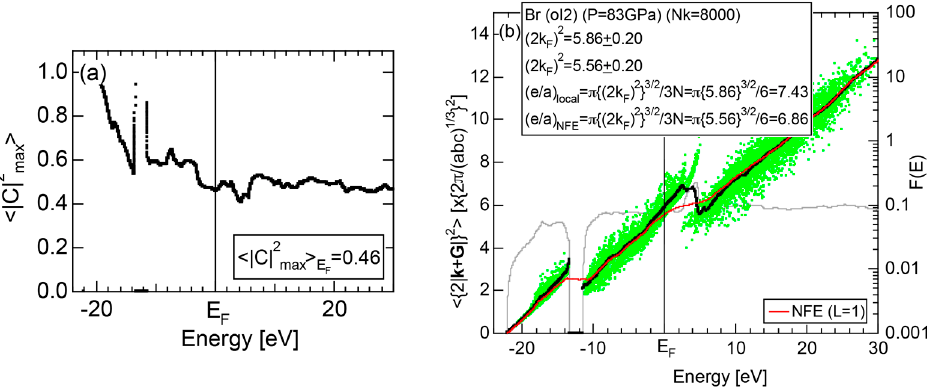
(cid:68) (cid:69) and ( b ) Hume-Rothery plot for metallic Br (oI2) synthesized under P = 83 C max2 | C | 2 ( a ) and ( b ) Hume-Rothery plot for metallic Br (oI2) synthesized max E E